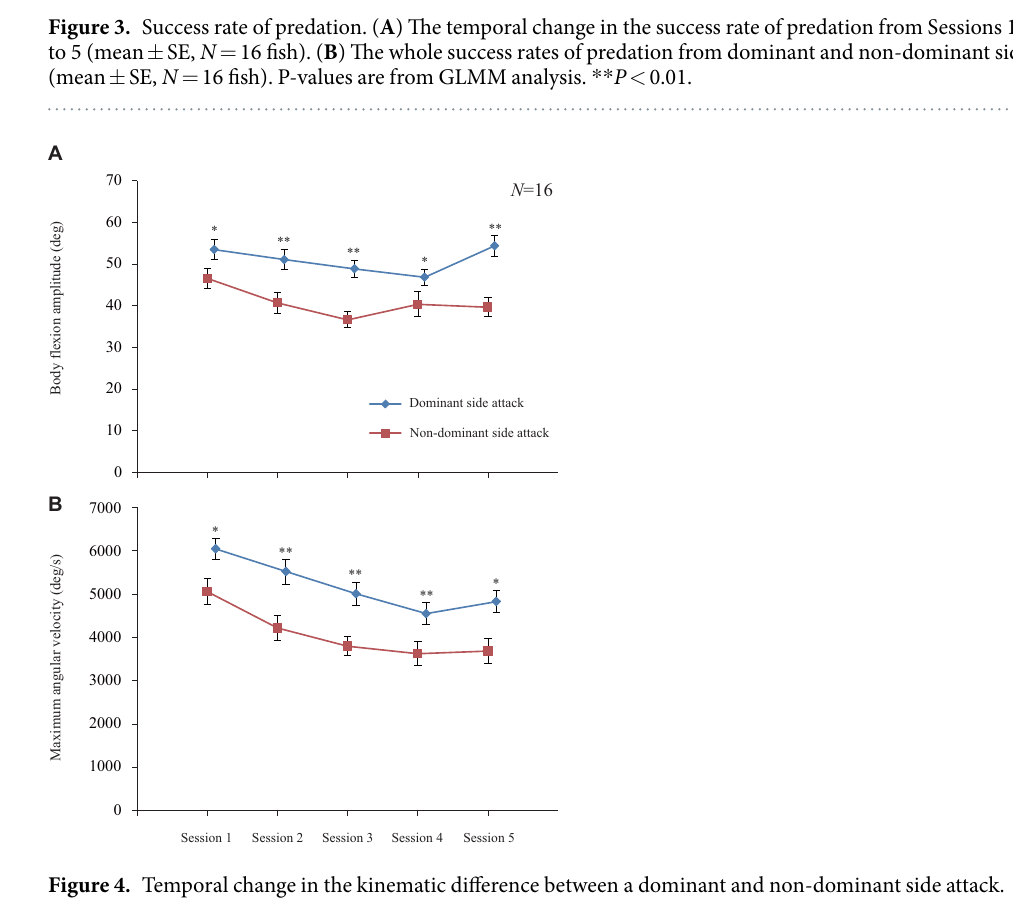
Figure 4. Temporal change in the kinematic difference between a dominant and non-dominant side attack. The change in the amplitude of body flexion ( A ) and maximum angular velocity ( B ) of predation from Sessions 1 to 5 (mean ± SE, N = 16 fish). P-values are from the Wilcoxon rank-sum test between dominant and non- dominant sides. * P < 0.05; ** P <